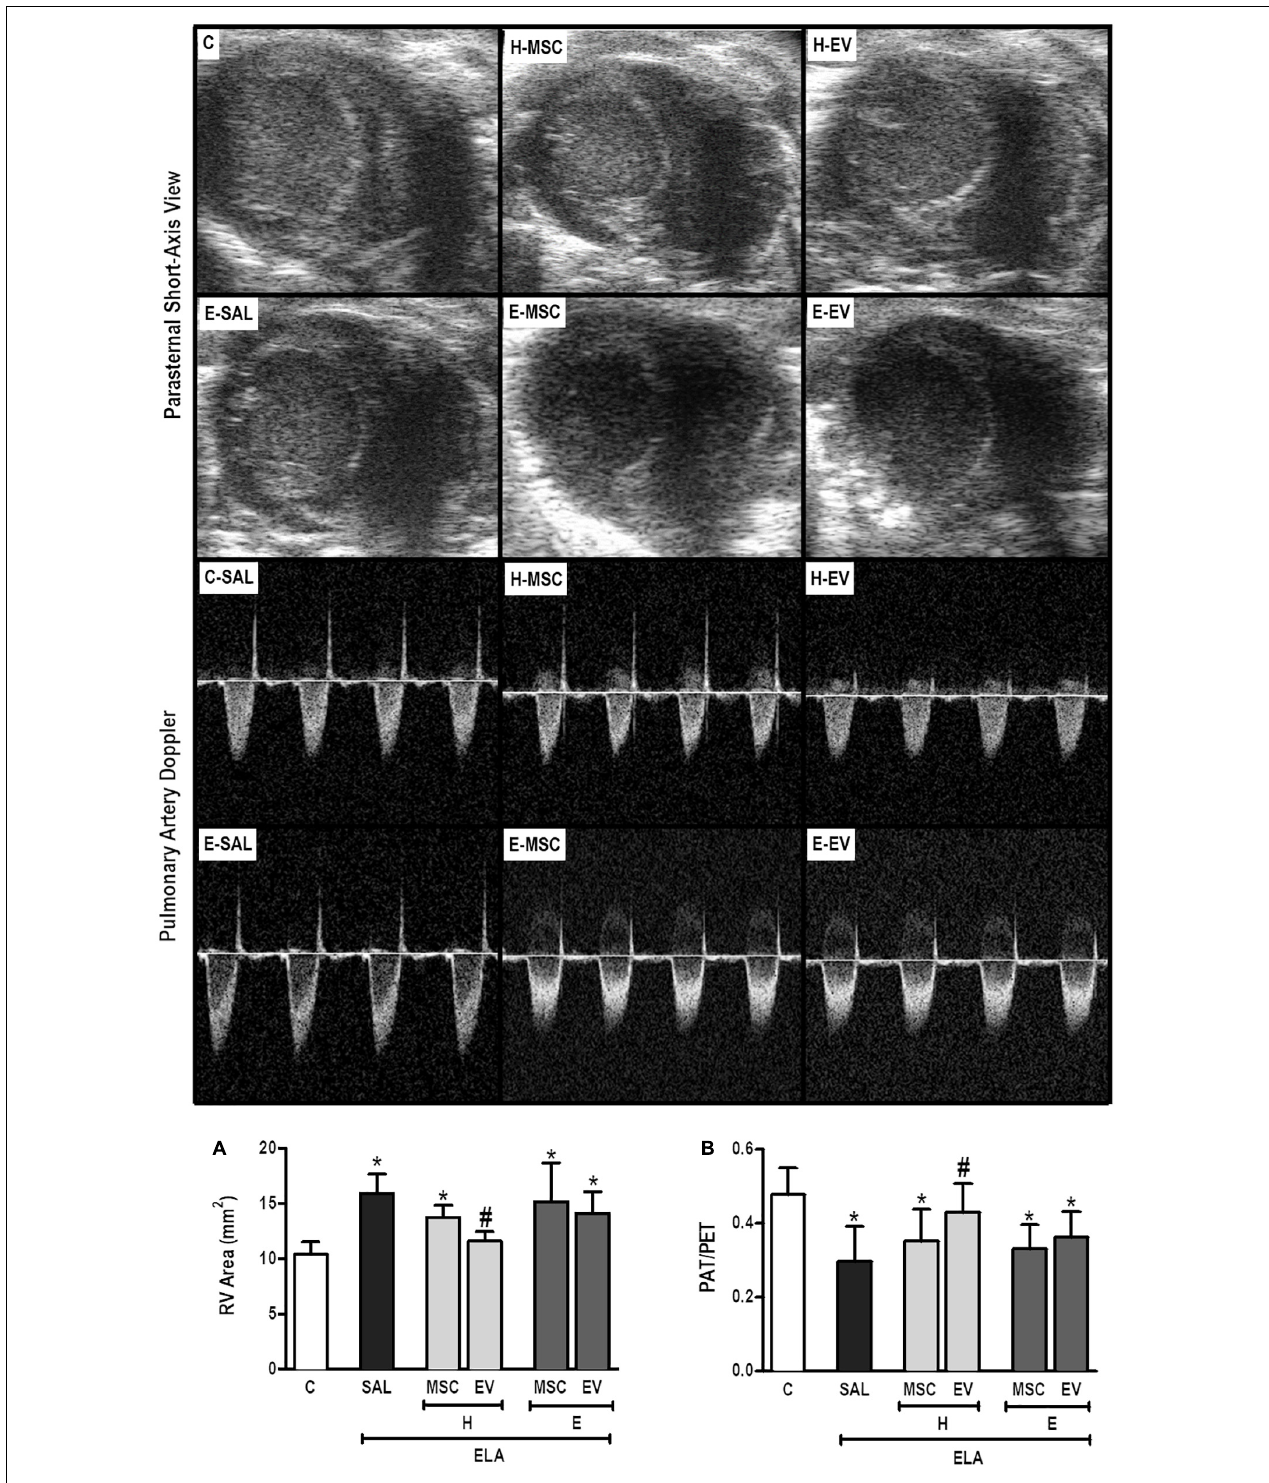
FIGURE 8 | Echocardiographic analysis. Parasternal short axis view of both ventricles (upper panel) and pulmonary artery flow dynamics (lower panel). (A) Pulmonary artery acceleration time/pulmonary artery ejection time ratio (PAT/PET) and (B) right ventricle area. C, intratracheal instillation of 50 µ L of saline; ELA, intratracheal instillation of 0.2 IU of pancreatic porcine elastase; SAL, intravenous injection of 50 µ L of saline; H-MSCs, 1 × 10 6 bone marrow-derived mesenchymal stromal cells (BM-MSCs) obtained from healthy donors; E-MSCs, 1 × 10 6 BM-MSCs obtained from emphysematous donors; H-EVs: extracellular vesicles derived from 1 × 10 6 BM-MSCs obtained from healthy donors; E-EVs, extracellular vesicles derived from 1 × 10 6 BM-MSCs obtained from emphysematous donors. RV, right ventricle. Data are expressed as means ± standard deviation of 7–10 animals/group. * P < 0.05 vs. the C group. # P < 0.05 vs. the ELA-SAL group.